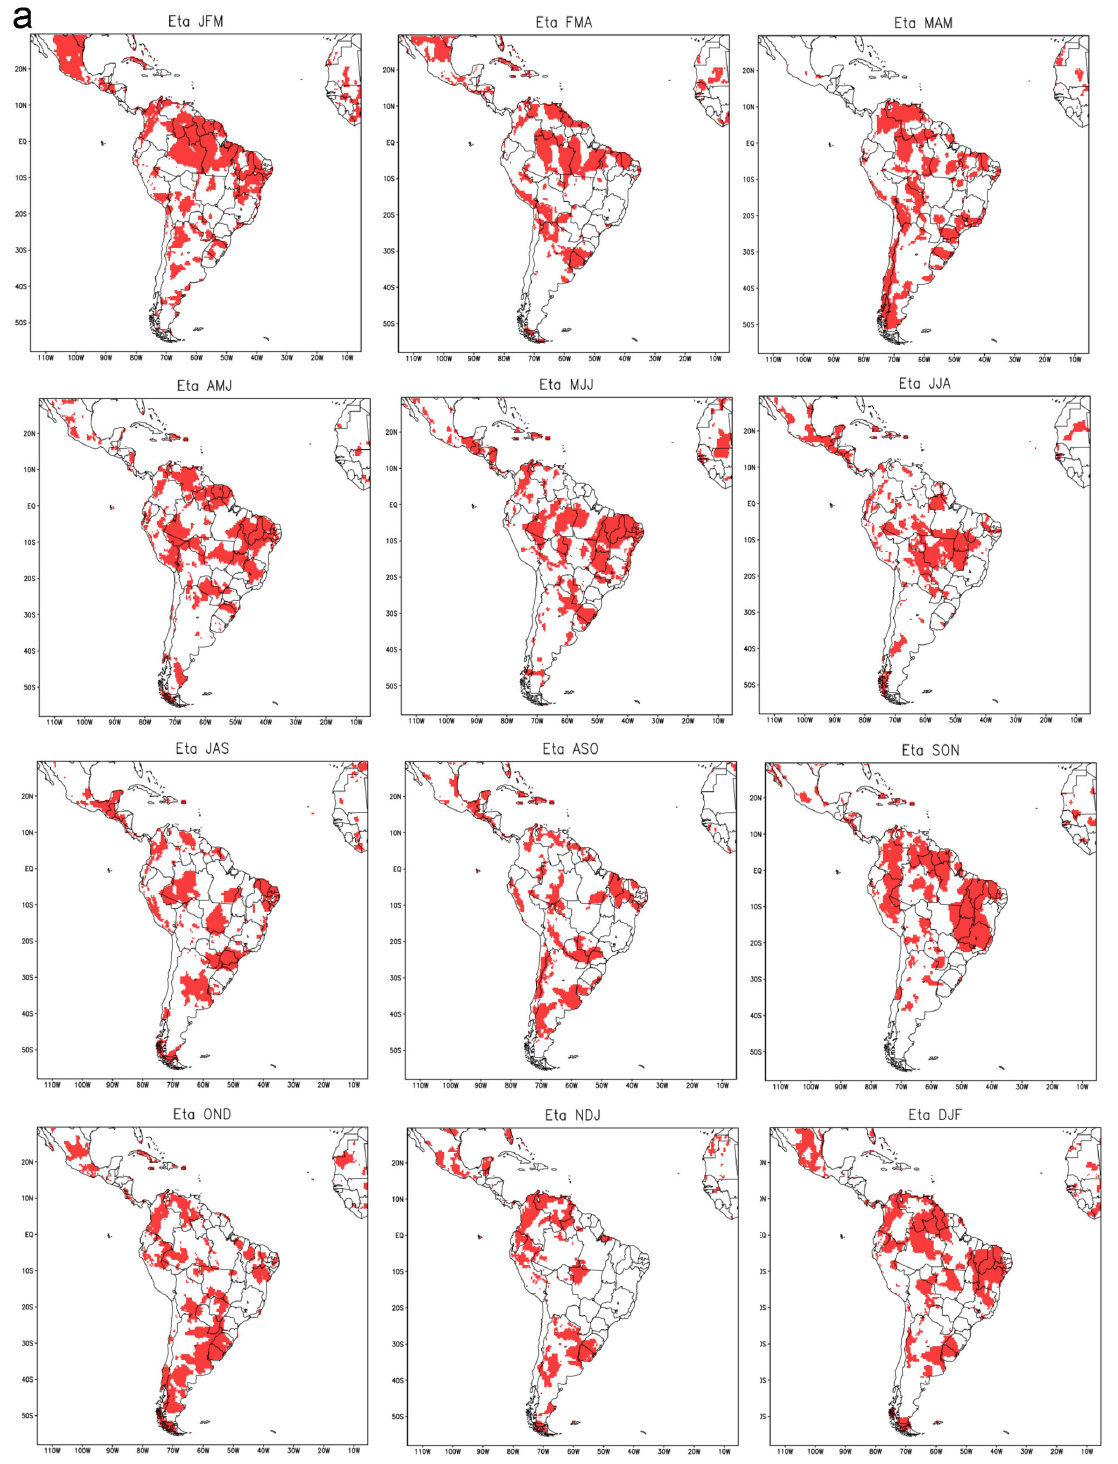
Figure 12. Precipitation skill scores greater than 0.3 for (a) the Eta RCM, and for (b) the CPTEC global atmospheric climate model with a two-month lead time for the seasons: JFM, FMA, MAM, AMJ, MJJ, JJA, JAS, ASO, SON, OND, NDJ, and DJF. The score is